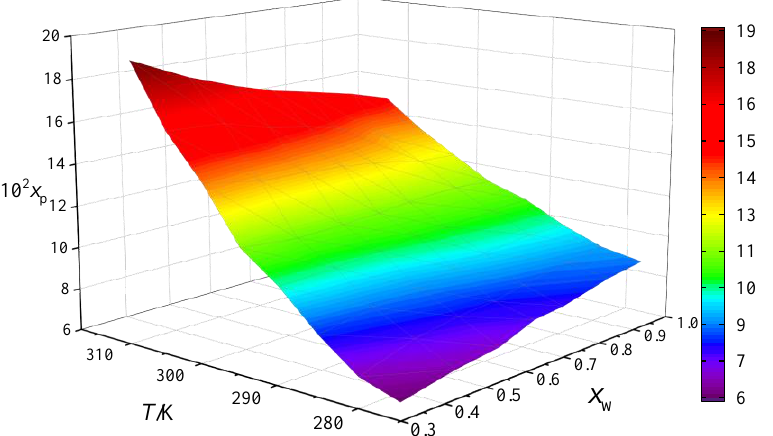
Figure 7. Mole fraction solubility of 1,5-pentanediamine adipate dihydrate in (water + methanol) mixed solvents with different mole fractions at various temperatures.